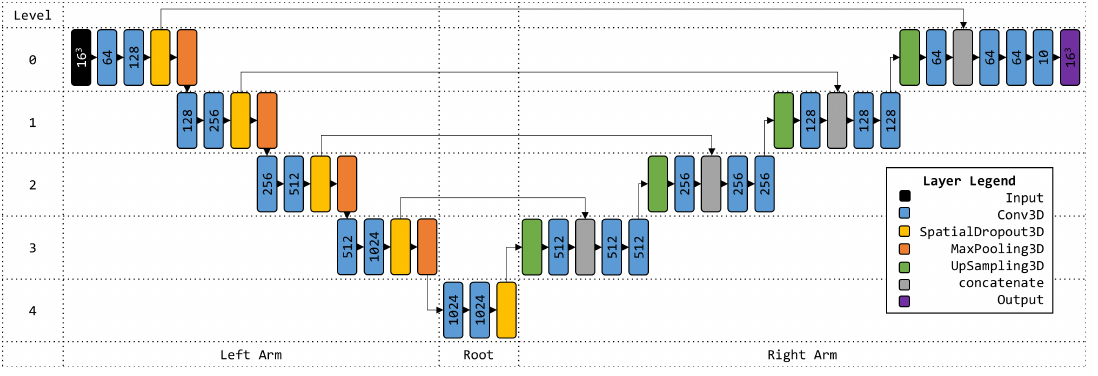
Figure 9. 3D U-Net Architecture. Filter counts are shown on Conv3D layers. Element dimension is shown for Input and Output